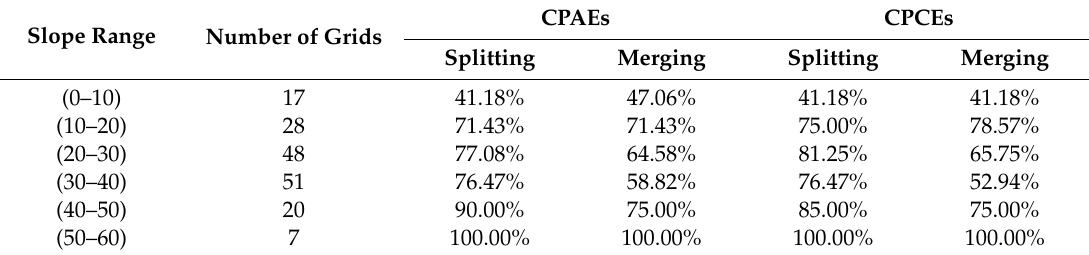
Table 2. The percentage of splitting and merging events in di ff erent slope